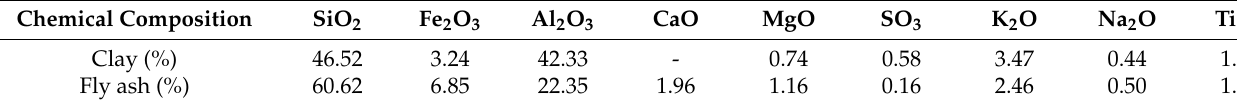
Table 2. Chemical composition of clay and fly ash. Table 3. Mechanical properties of polypropylene (PP) fiber. Table 3. Mechanical properties of polypropylene (PP) fiber.